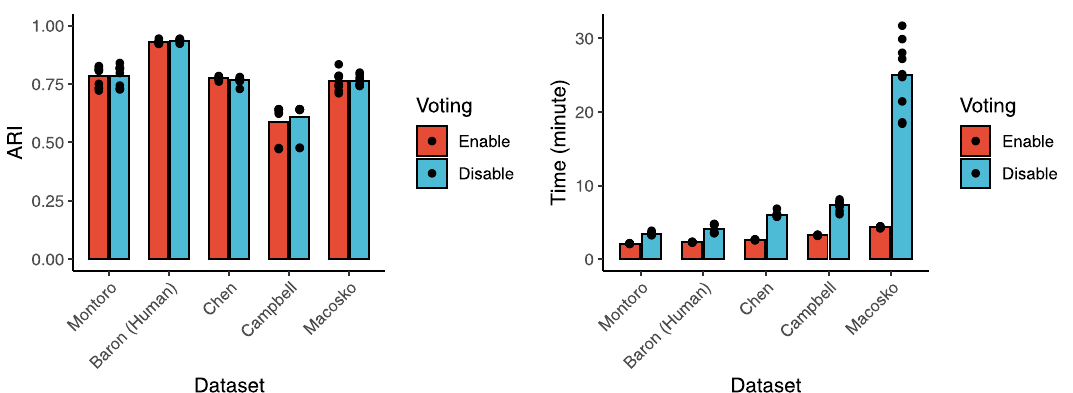
Fig. 5 Accuracy and running time of scDHA on large data sets with and without using the voting procedure. The voting procedure signi fi cantly reduces the running time without compromising the accuracy. Each point represents the result of a single run, while the bar shows the average of 10